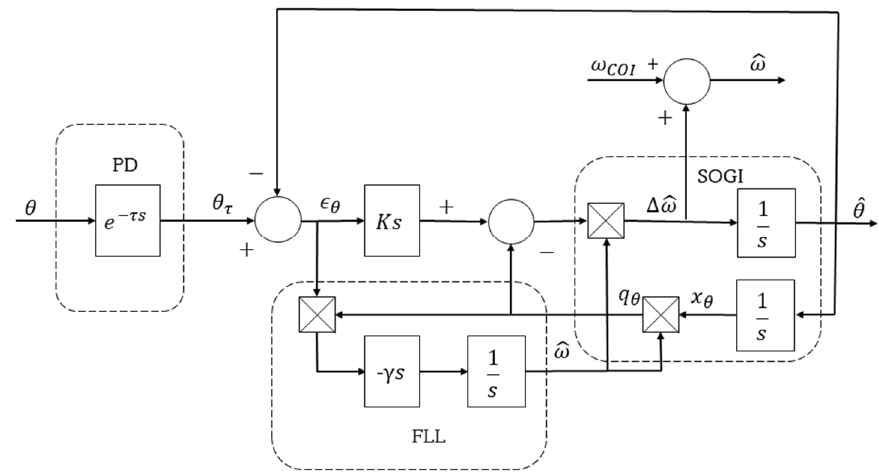
Figure 6. Diagram of the SOGI-PLL.